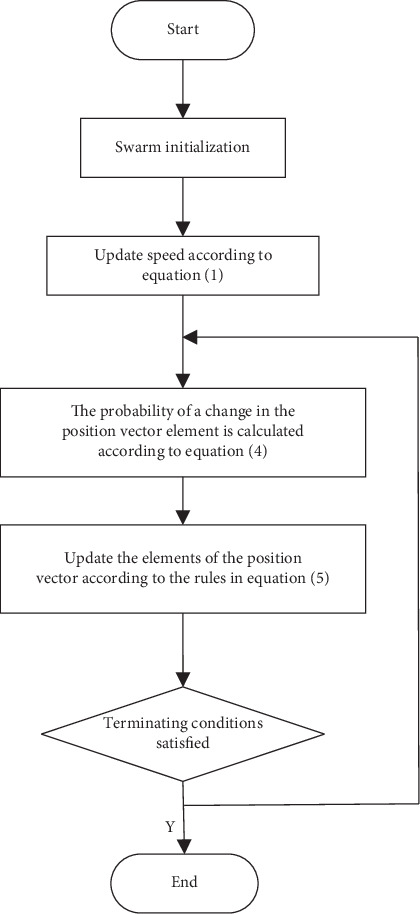
Flow chart of BPSO algorithm.